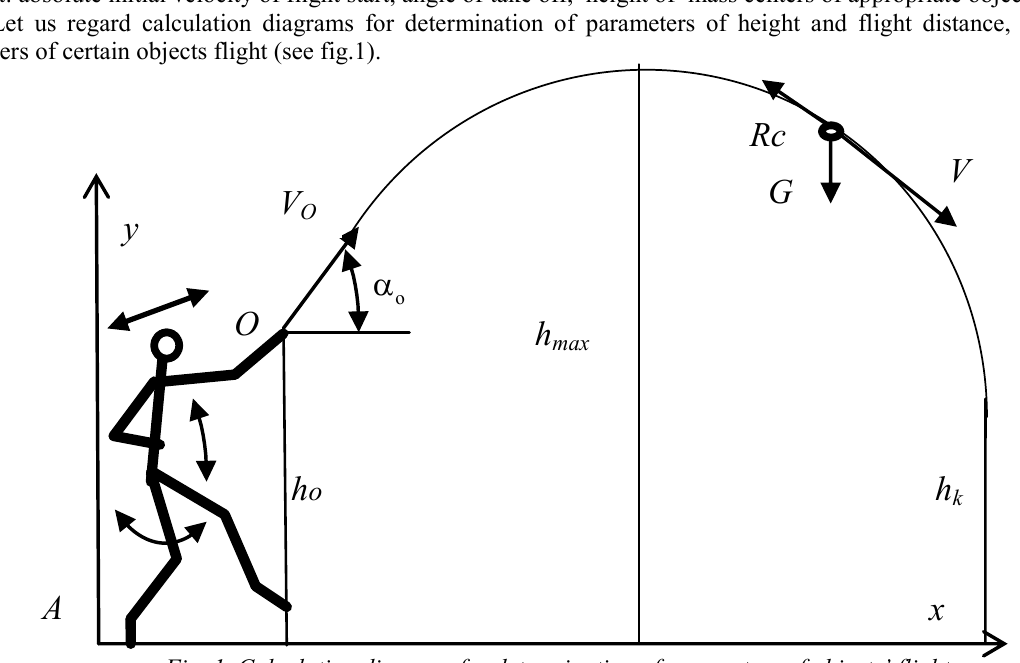
Fig. 1. Calculation diagram, for determination of parameters of objects’